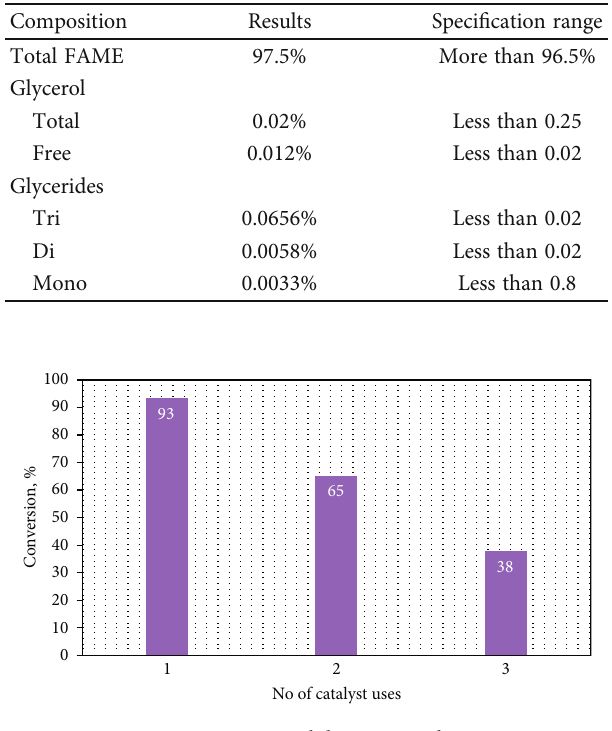
Figure 13: Reusability test results.